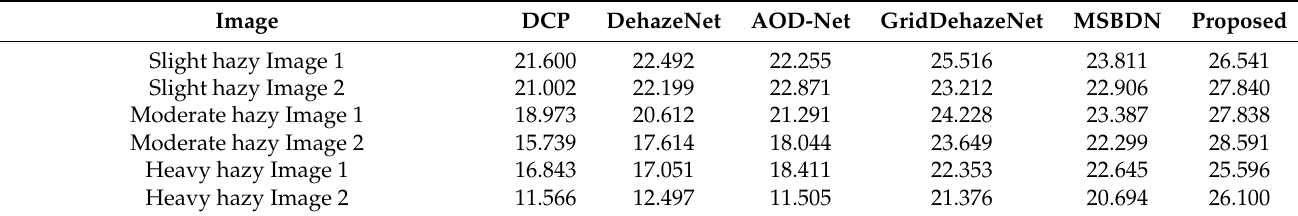
Table 5. Experimental results on different images: PSNR.